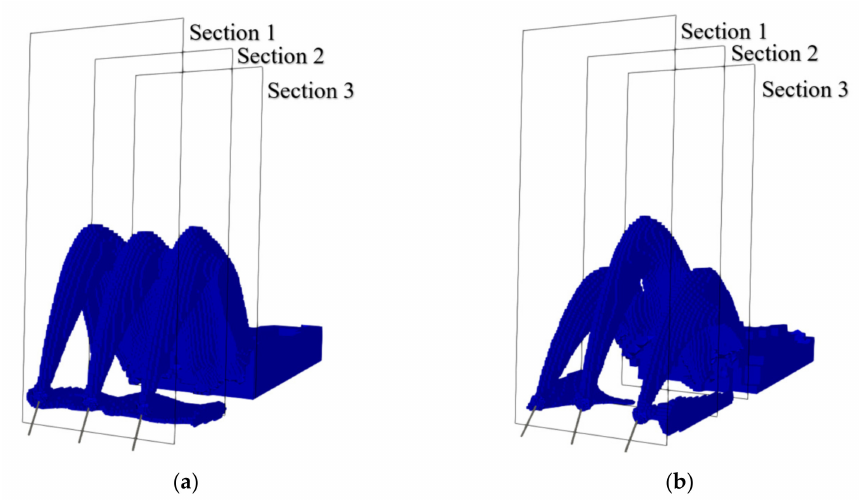
Figure 8. Visualization of ( a ) uniform (case C2) and ( b ) non-uniform (case S1) inclined dense jets, using a velocity isosurface (U = 0.015 m/s).